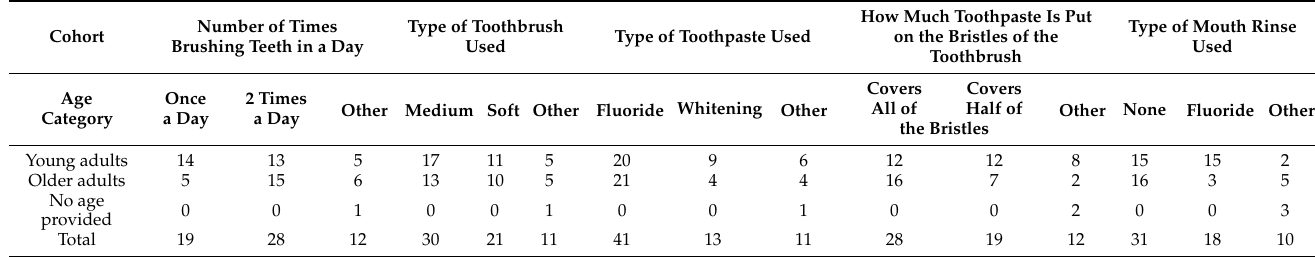
Table 2. Participants’ health in relation to their oral health.